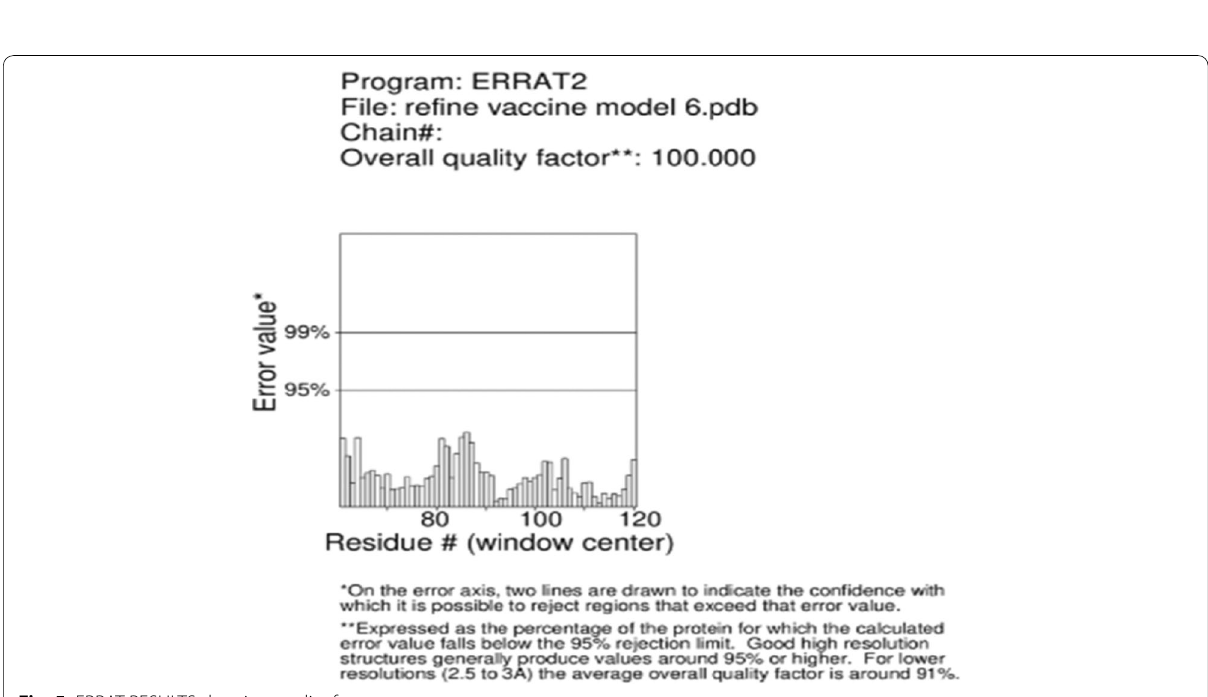
Fig. 5 ERRAT RESULTS showing quality